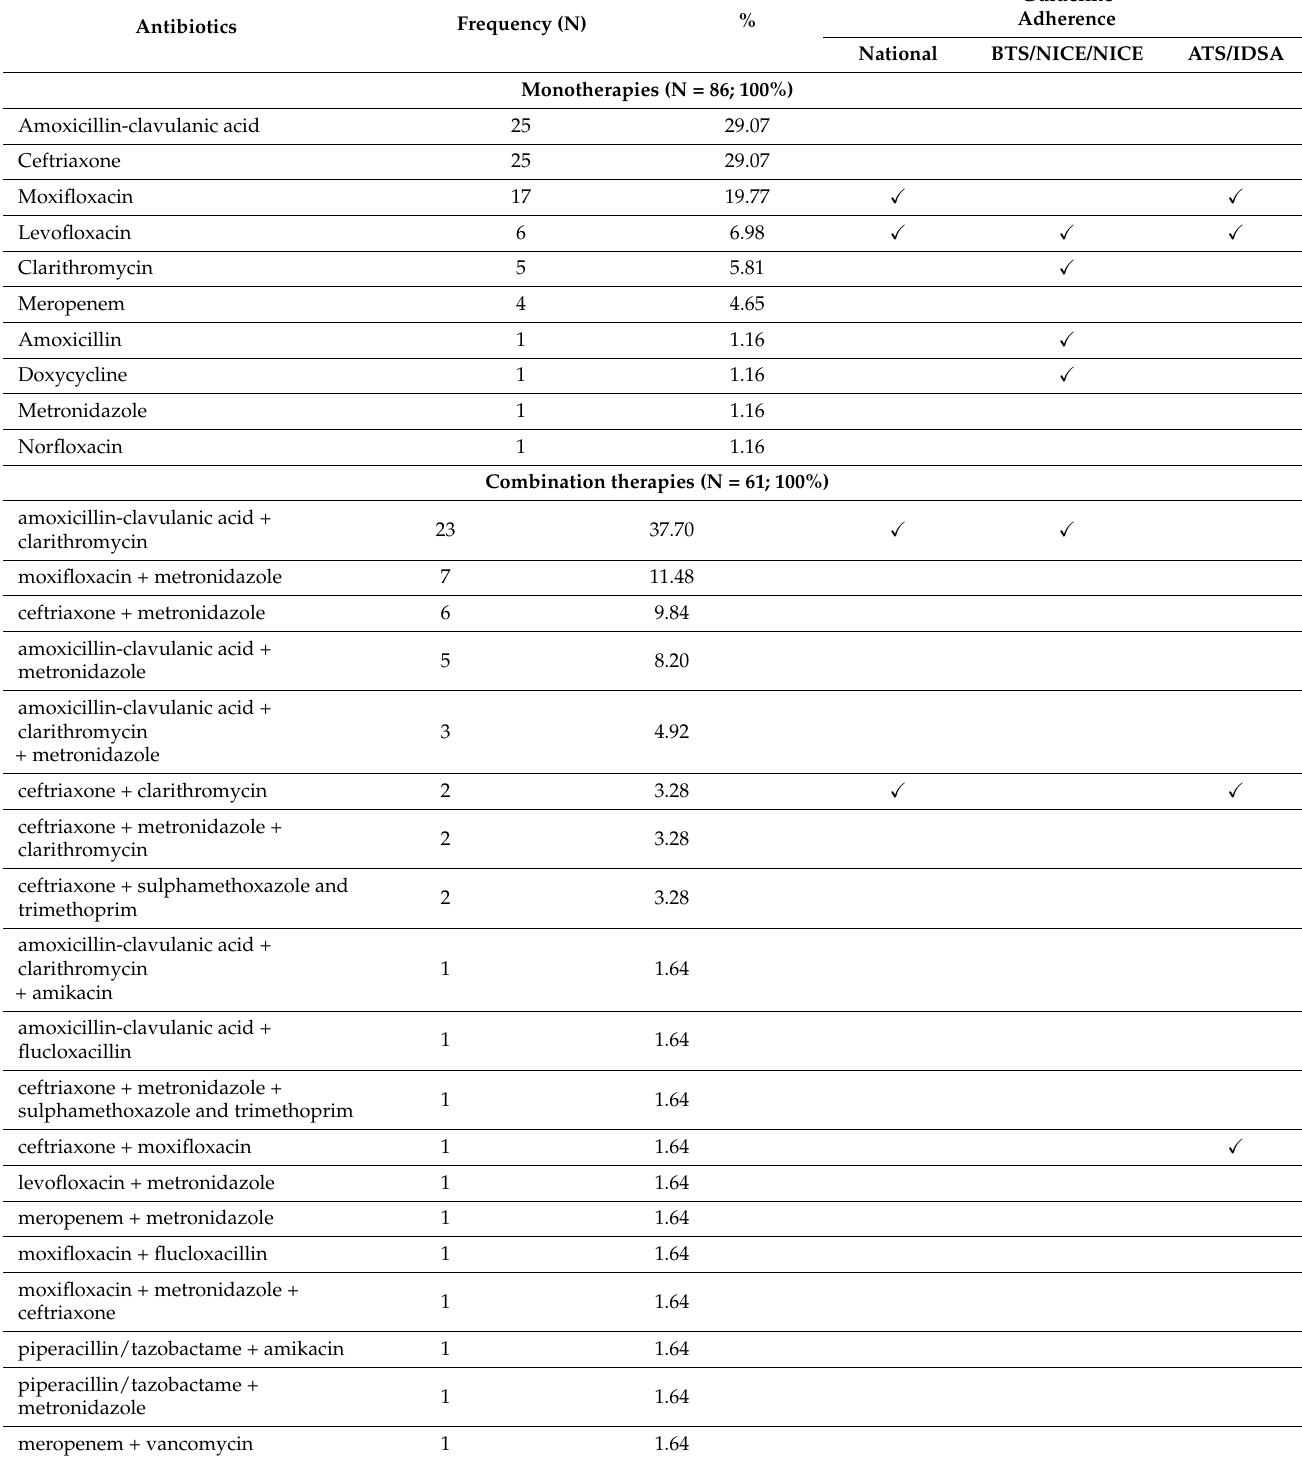
Table 2. The distribution of first empirical antibiotic therapies (mono- and combination